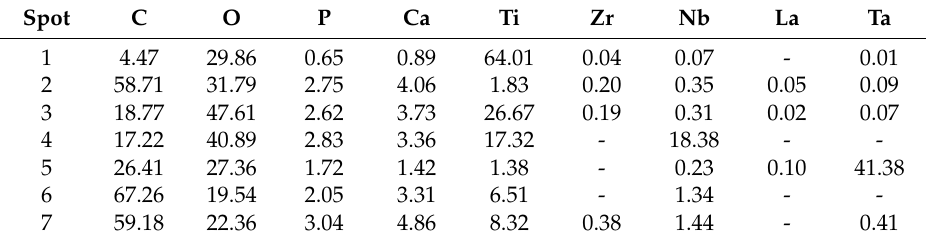
Table 2. The dispersive X-ray spectroscopy (EDS) results (at. %) in Figure 3. Spot